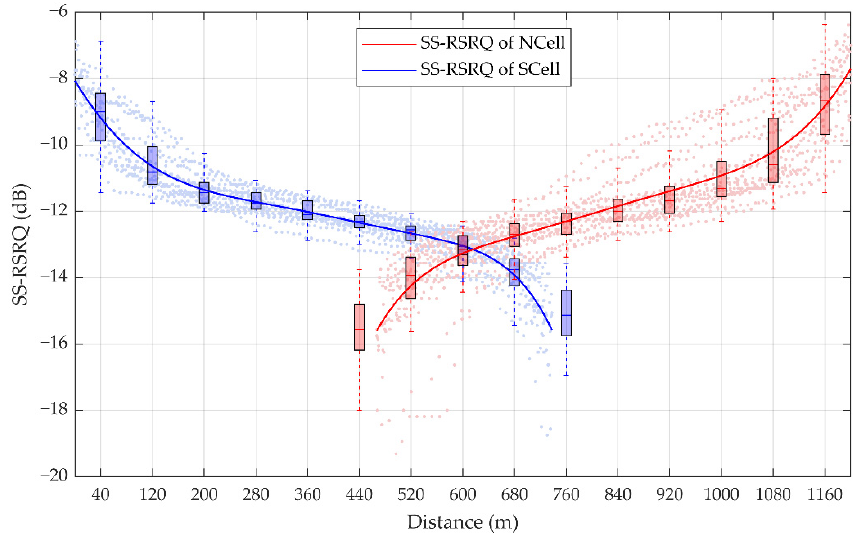
Figure 7. Statistics of the synchronization signal reference signal receiving quality (SS-RSRQ) measurement. The box plots denote the statistic of SS-RSRQ in each 80 m. For a certain box, the bottom is the lower quartile Q1, the top is the upper quartile Q3, the horizontal line in the middle of the box is the median Q2; the top of the whisker is O3 + 1.5IQR, and the bottom is Q1 − 1.5IQR, where IQR is the interquartile range IQR = Q3 − Q1.